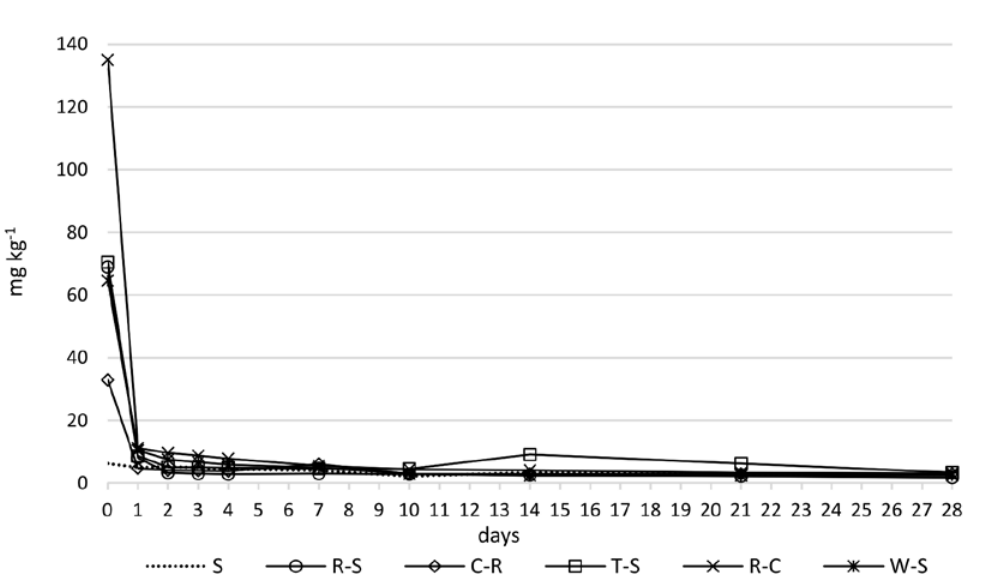
Figure 1. Daily production of (a) methane (expressed as CH 4 -C) and (b) carbon dioxide (expressed as CO 2 - C) from soils amended with digestates. Amendments: R-S = Reed sweet-grass digestate, C-R = Common reed digestate, T-S = Tufted sedge digestate, R-C = Reed canary grass digestate, W-S = Woollyfruit